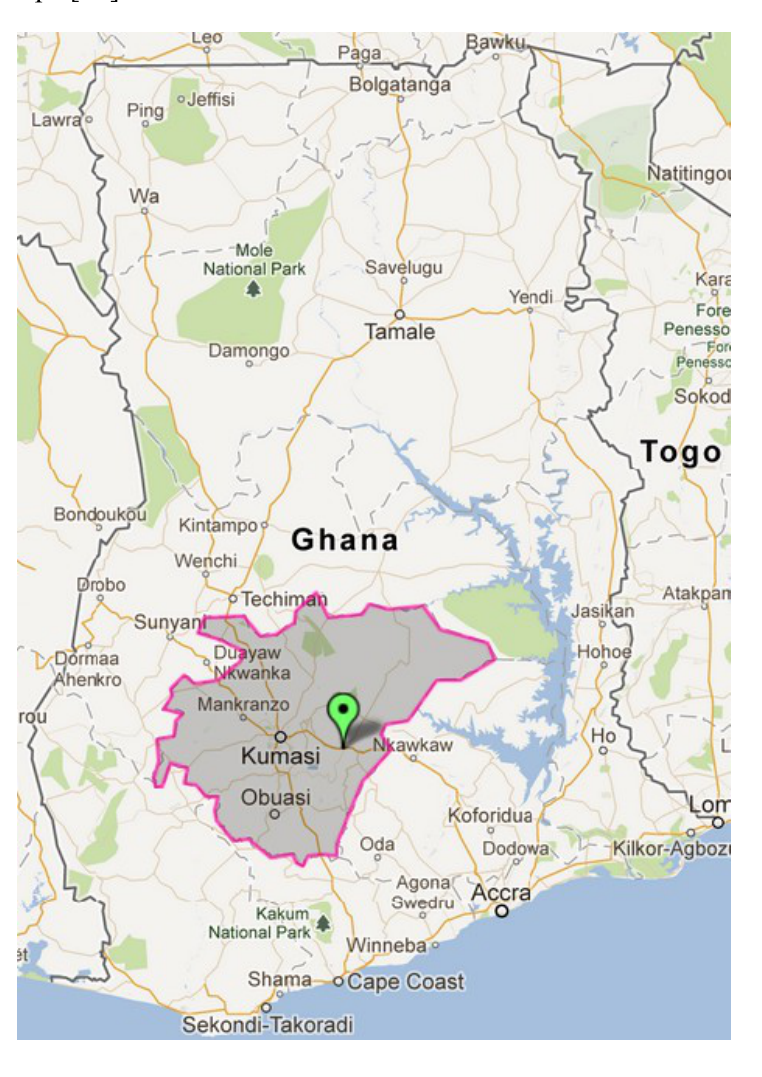
Figure 1. Location of Konongo in the Ashanti region of Ghana (N 8.58102 W 0.68115); Courtesy: Zee maps